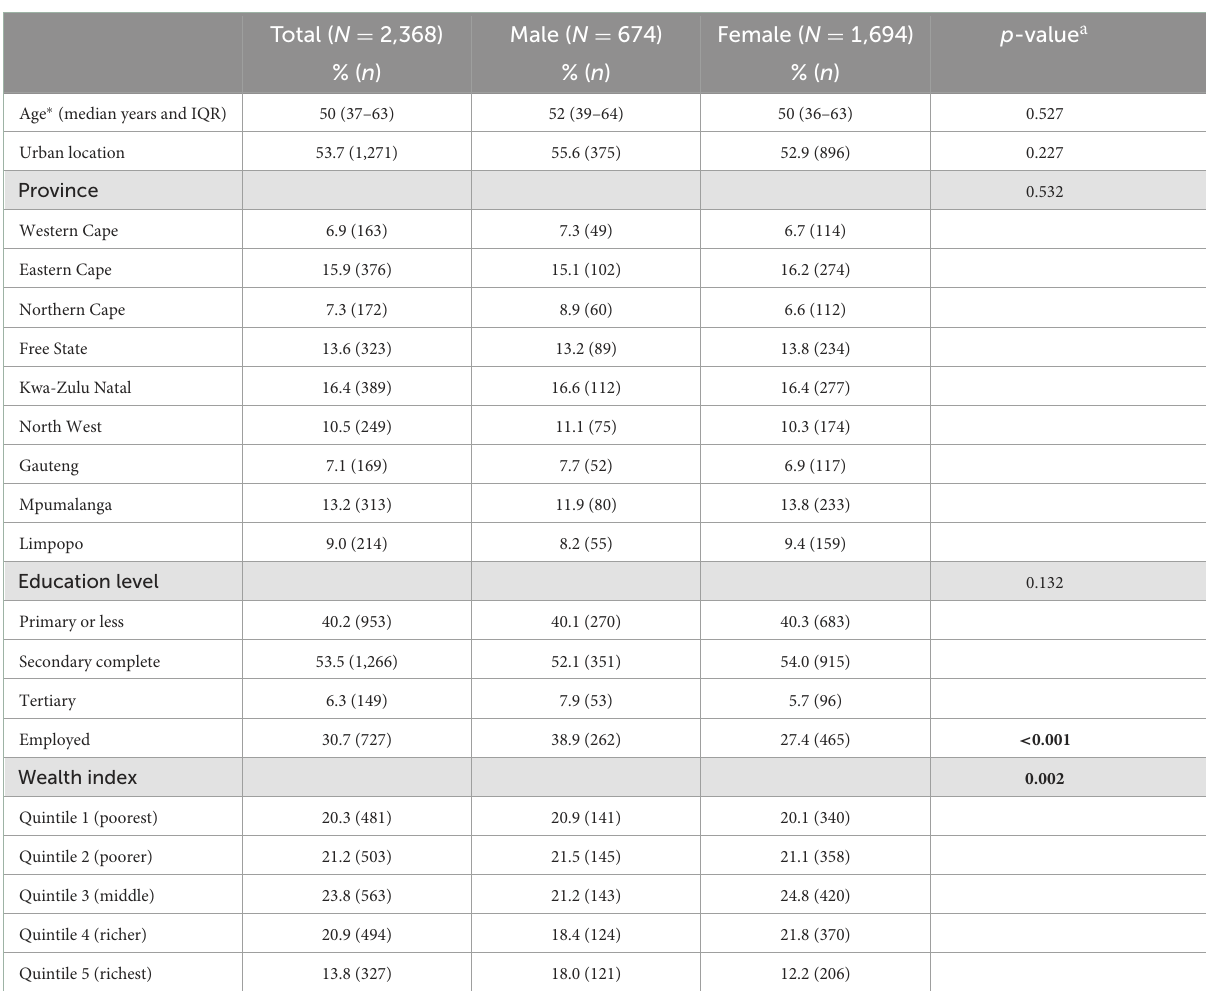
TABLE 1 Description of the multimorbid population by sex